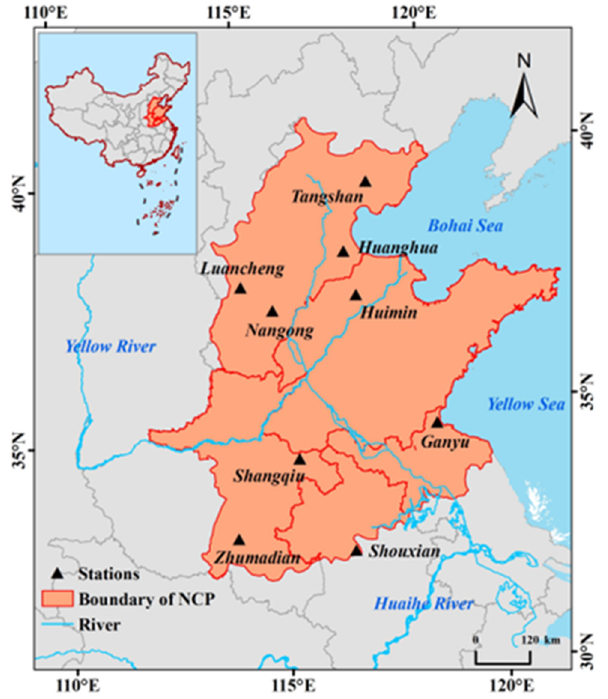
Figure 1. Location of the North China Plain.